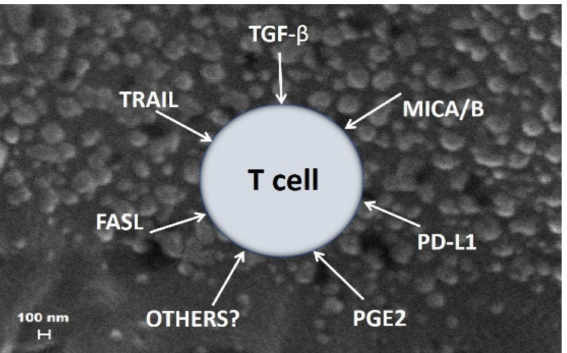
Figure 4. An imaginary view of multiple sEV in plasma of a cancer patient. Tumor-derived sEV such as MTEX carry various immunosuppressive cargos and interfere with anti-tumor functions of activated T cells in the circulation. Note that the T cell found in the midst of sEV is simultaneously subjected to different inhibitory signals that engage multiple suppressive pathways, leading to loss of T cell functions and/or to T cell apoptosis. Reproduced from ref